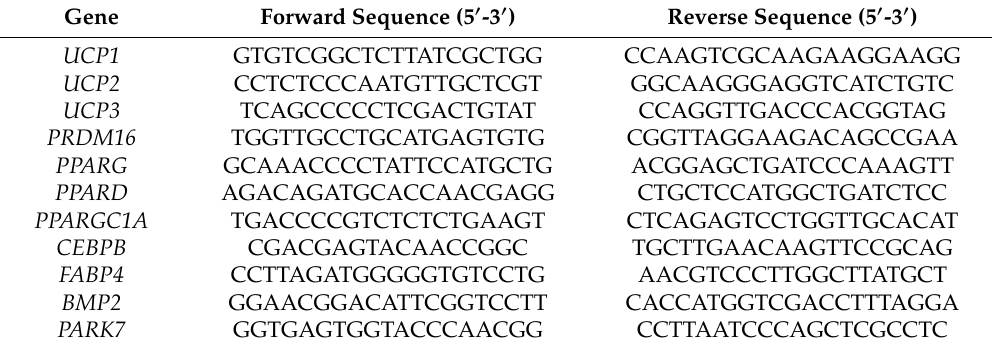
Table 1. Primer sequences used for quantitative real-time